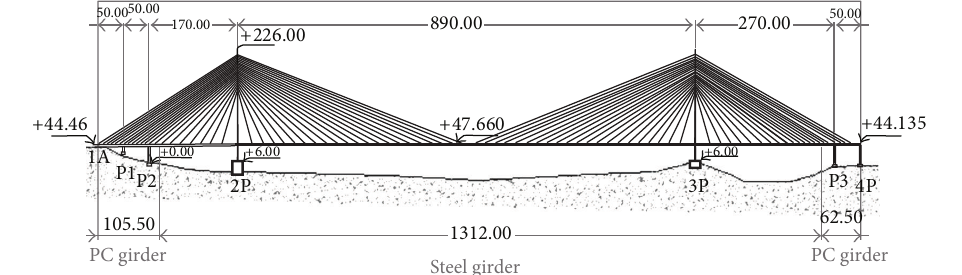
Figure 4: General arrangement of the Tatara cable-stayed